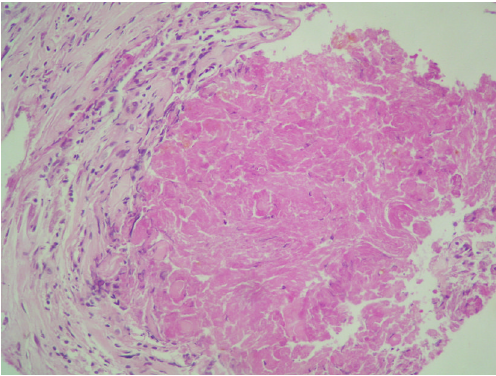
Figure 3: Histological examinationscore (HES) showing granulo- matous inflammation with caseous